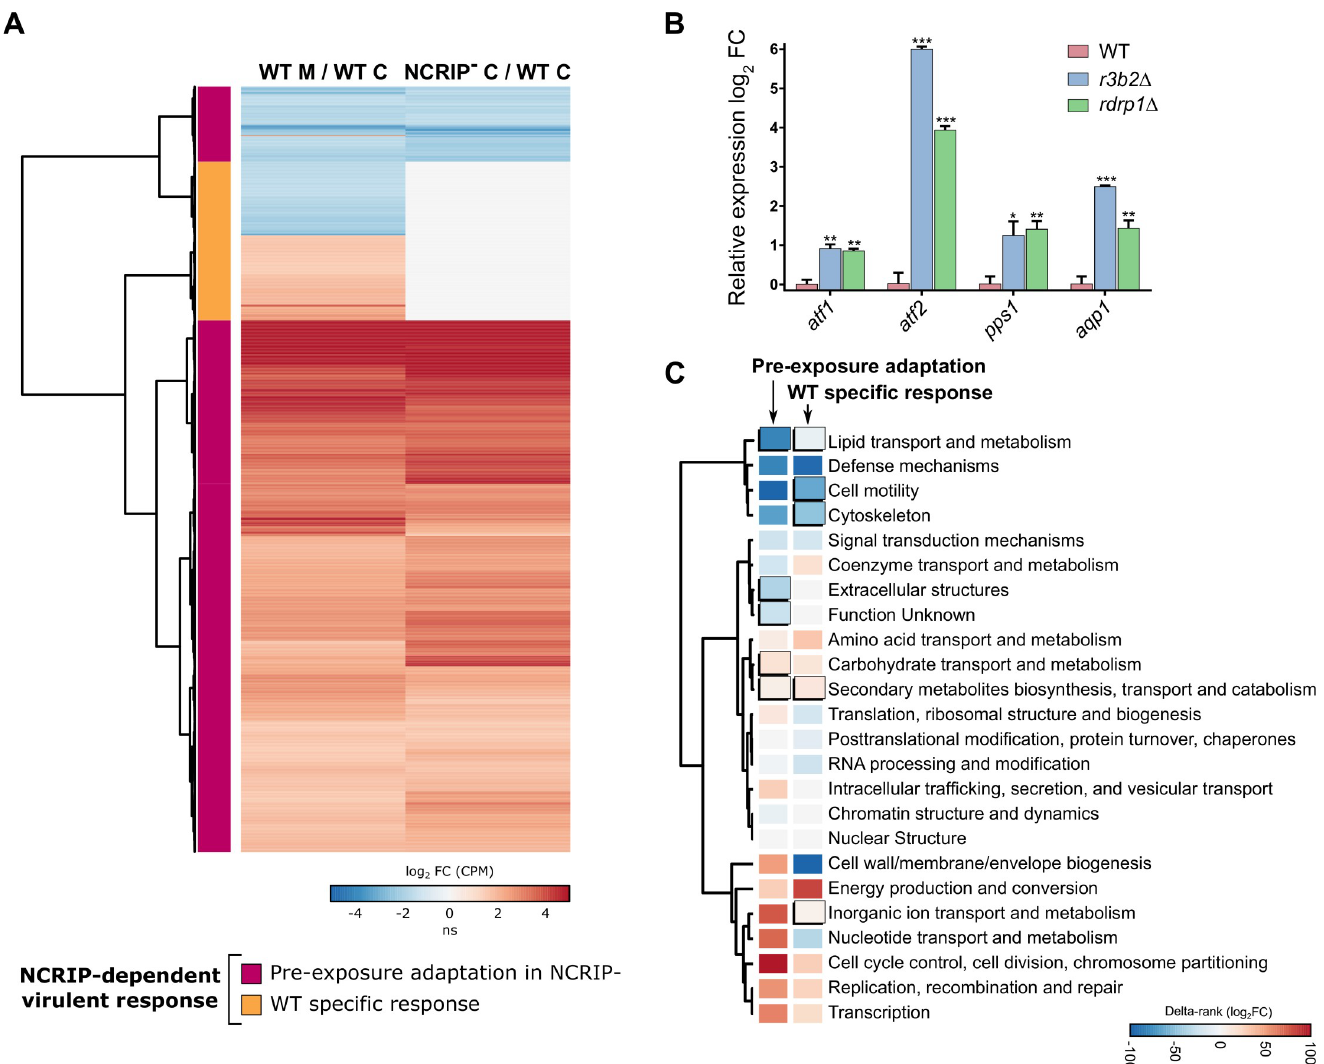
Fig 4. NCRIP controls the response to macrophage phagocytosis by inhibiting its targets under non-stressful conditions. (A) The NCRIP-dependent virulent response is depicted in a heatmap. Genes are clustered by similarity to compare the response to phagocytosis in the wild-type strain and the response of the NCRIP mutants in saprophytic conditions. This comparison reveals a pre-exposure adaptation of the NCRIP mutants (magenta cluster), showing similar expression values than the wild-type response to phagocytosis. Exclusive genes of the wild-type response are clustered together (orange cluster). Differential expression values (in log 2 CPM) are color-coded to depict the degree of upregulation (red) or downregulation (blue) in each condition (ns stands for non-significant changes). (B) Bar plot of atf1 , atf2 , pps1 and aqp1 expression differences in r3b2 Δ , and rdrp1 Δ mutant strains compared with the wild-type strain in non-stressful conditions, i.e., incubation in cell-culture medium without macrophages for 5 hours. Log 2 fold-change differential expression levels were quantified by RT-qPCR and normalized using rRNA 18S as an internal control. Error bars correspond to the SD of technical triplicates and significant differences are denoted by asterisks ( � for P � 0.05, �� for P � 0.005, and ��� for P < 0.0001 in an unpaired t-test). (C) KOG class enrichment analysis of the NCRIP-dependent virulent response during macrophage interaction is grouped in pre-exposure adaptation in NCRIP mutants and wild-type specific responses. Significant enrichments (Fisher’s exact test, P � 0.05) are shown as uplifted rectangles. A measure of up- (red) or downregulation (blue) of each KOG class is represented as a colored scale of delta-rank values (the difference between the mean rank differential expression value of all genes in a particular KOG class and the mean rank differential expression value of all other genes). KOG classes are clustered according to the similarity of their delta rank values. LINE1 transcripts in the pericentric regions of the wild-type strains and the r3b2 Δ and rdrp1 Δ mutants (Fig 6A). The pericentric regions are almost depleted of sRNAs in the ago1 Δ and dcl1 dcl2 Δ mutants, whereas the wild-type strain exhibited an active production of sRNAs aligned to these loci, as previously reported [12]. Interestingly, the r3b2 Δ and rdrp1 Δ mutants